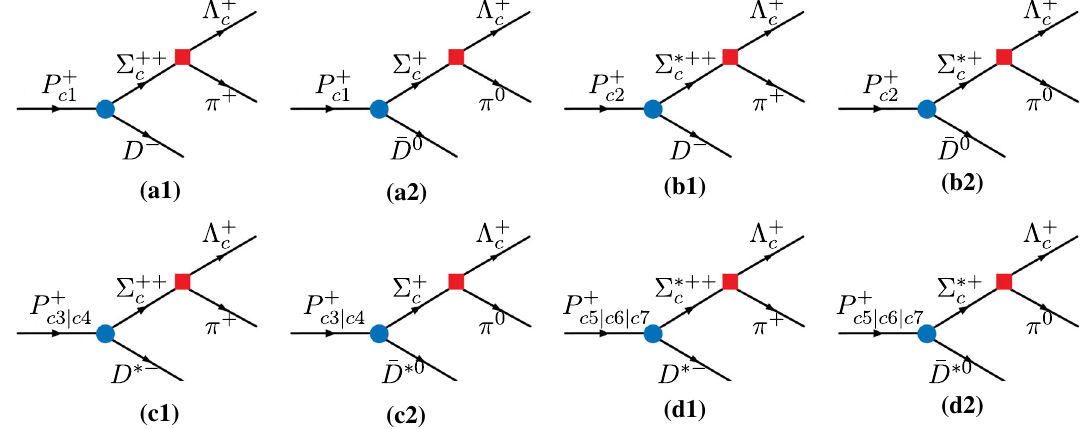
Fig. 1 Tree-level diagrams for the decays of P c 1 → ¯ D (cid:2) c → ¯ D (cid:4) c π ( a ), P c 2 → ¯ D (cid:2) ∗ c → ¯ D (cid:4) c π ( b ), P c 3 | c 4 → ¯ D ∗ (cid:2) c → ¯ D ∗ (cid:4) c π ( c ) and